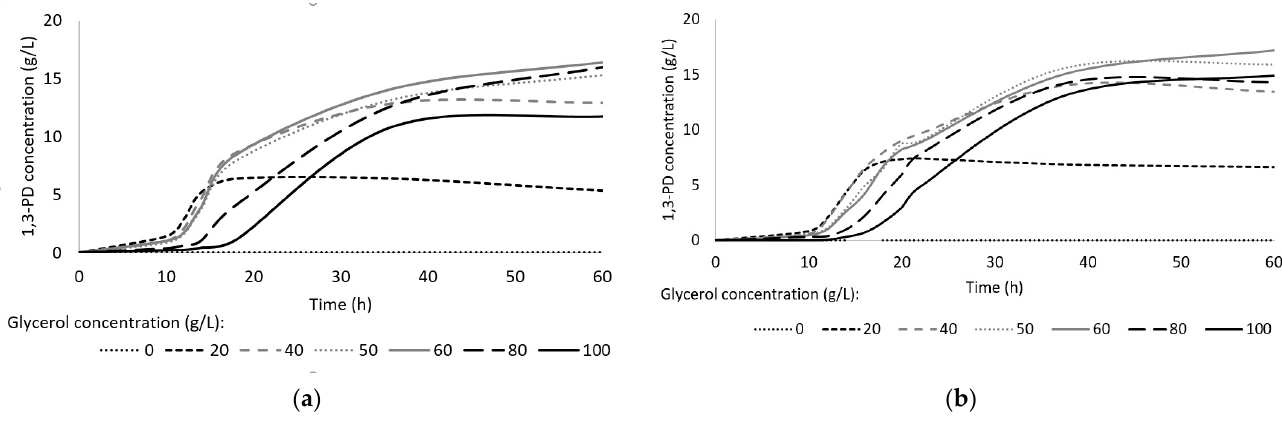
Figure 4. Effect of initial glycerol concentration on 1,3-PD production using pure glycerol ( a ) and crude glycerol ( b ).